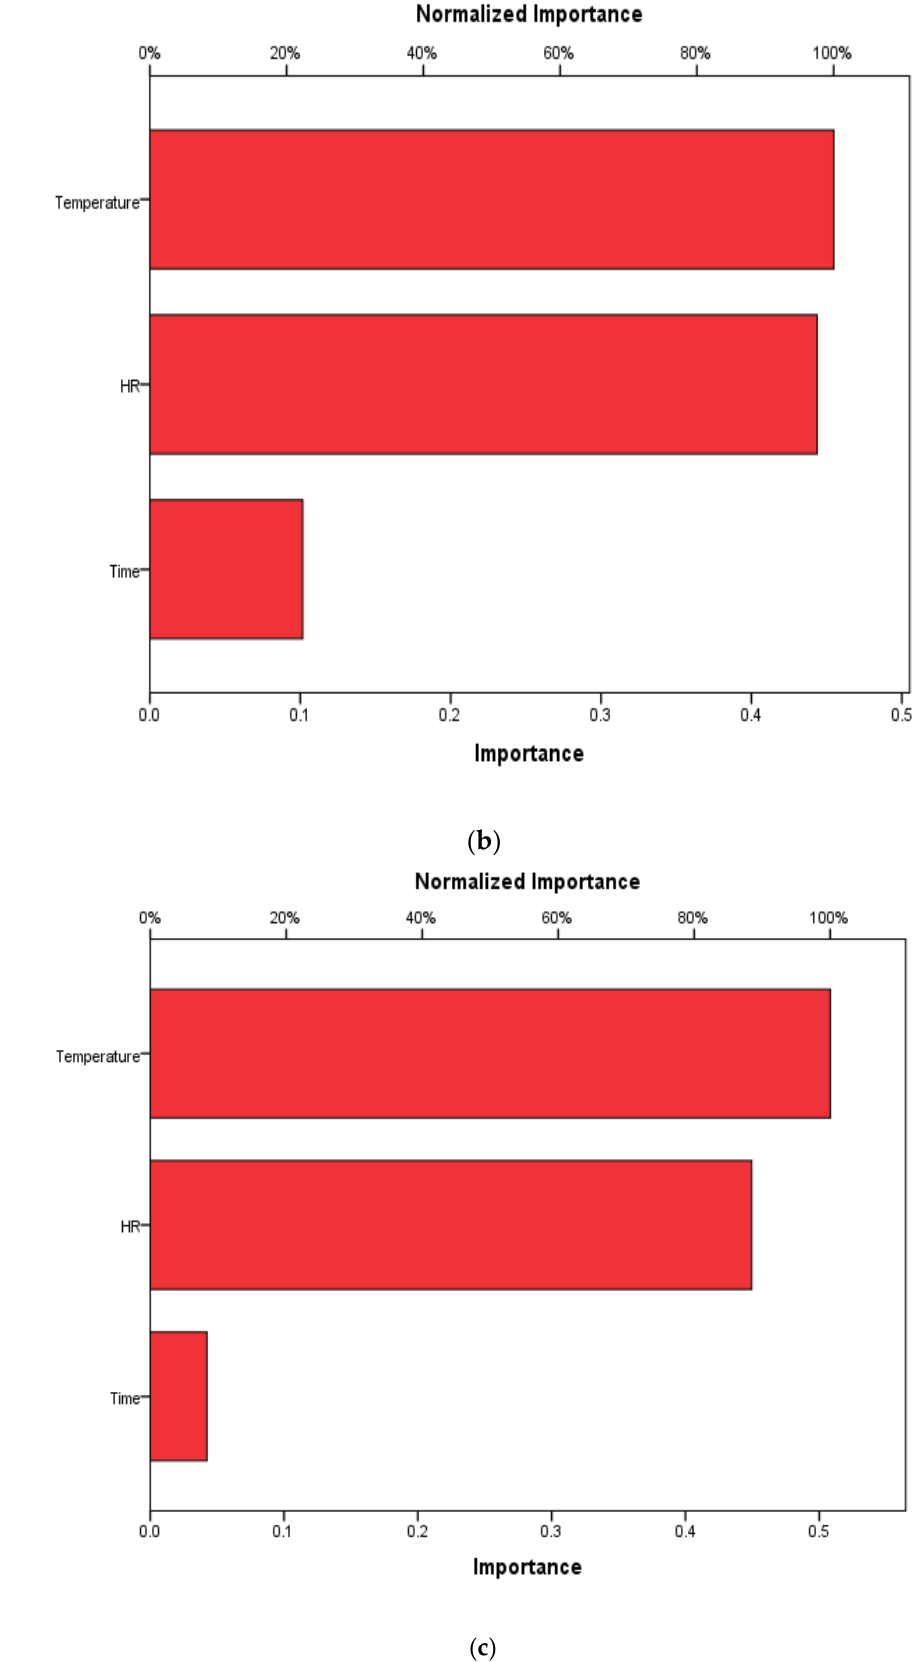
Figure 8. Relative importance of input variable to the ANN prediction of mass loss at heating rate of ( a ) 10 °C/min; ( b ) 20 °C/min; ( c ) 30 °C/min. ( a ) 10 ◦ C/min; ( b ) 20 ◦ C/min; ( c ) 30 ◦